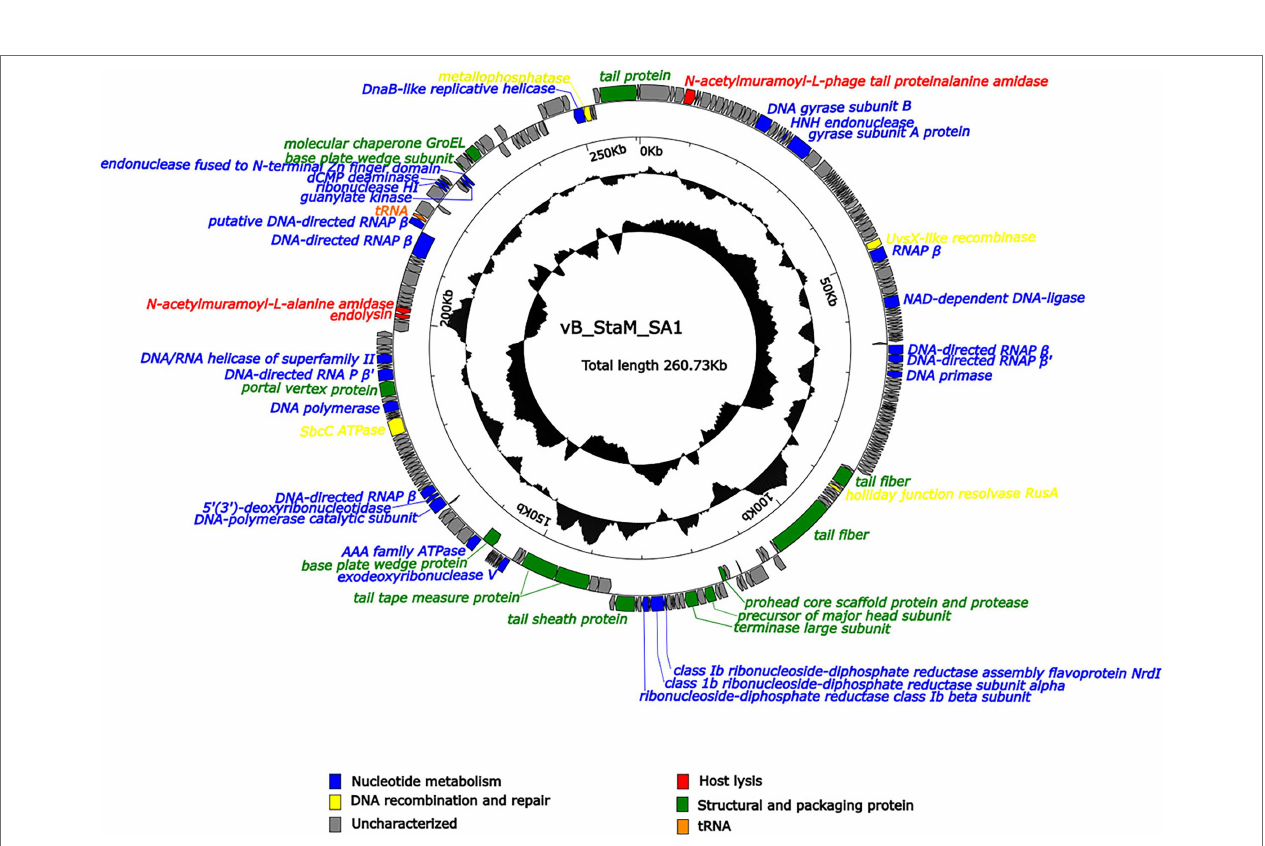
FIGURE 3 | Bacterial reduction assay of phage SA1 against S. lentus JTB1-3 at various MOIs (1,0.1 and 0.01). The data are expressed as means ± SD ( n = 3).